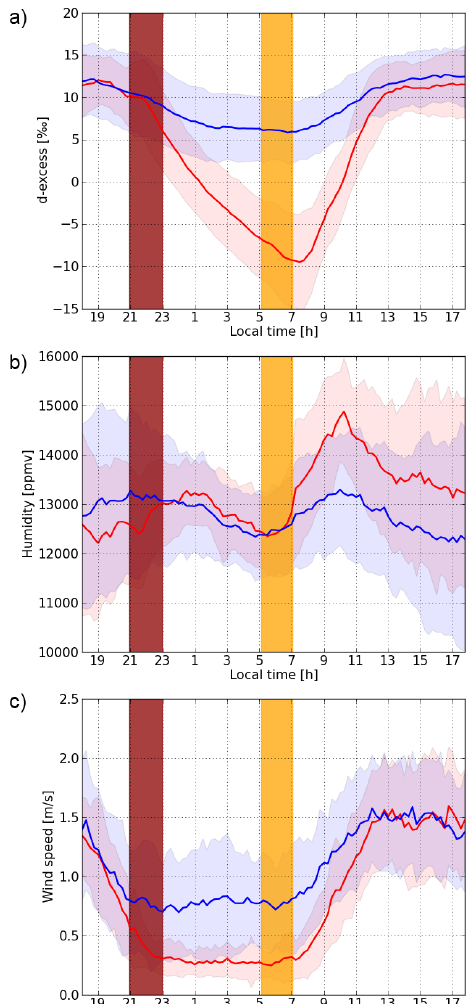
Figure 9. Dominant clusters for (a) d-excess, (b) humidity and (c) Fig. 9. Dominant clusters for (a) d-excess, (b) humidity and (c) wind speed. Yellow bars: sunrise time, wind speed. Red line: Cluster 1, blue line: Cluster 2, yellow bars: dark red bars: sunset time. The shading shows the standard deviation for each cluster. sunrise time, dark red bars: sunset time. The shading shows the stan- dard deviation for each